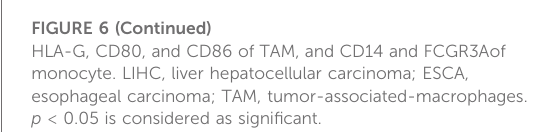
FIGURE 6 Correlation of WTAP expression with immune cell speci fi c gene markers in LIHC and ESCA. Immune cells, including B cells, M1/M2 macrophages, tumor-associated macrophages (TAM), monocytes are characterized respectively in LIHC and ESCA. Markers include CD19, MS4A1, and CD38 of B cell, NOS2 and ROS1 of M1 macrophage, ARG1 and MRC1 of M2 macrophage,